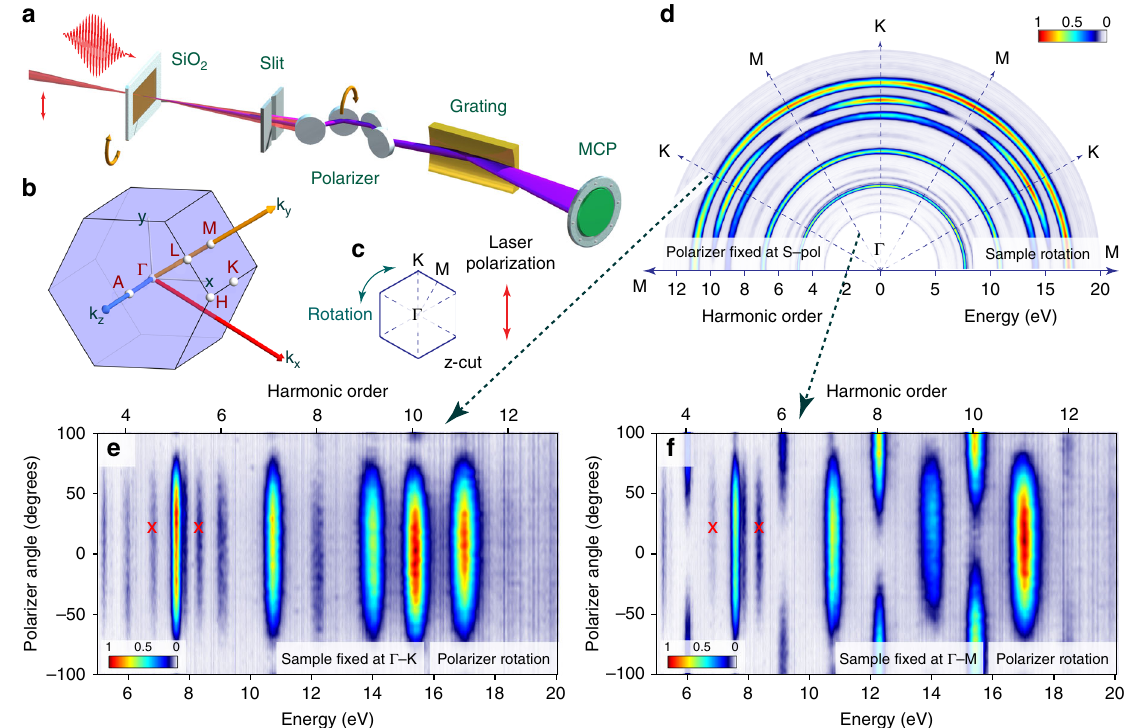
Fig. 2 Unveiling physical mechanisms of even-harmonic generation from the α -quartz. a Experimental apparatus showing the spectral measurement with rotatable target and EUV polarizer. b Perspective view of the Brillouin zone of α -quartz showing both the Cartesian coordinates, as well as k -vectors. c Projection of the Brillouin zone for a z-cut α -quartz crystal. d Recorded spectral intensity (false-color) as a function of the rotation angle of the α -quartz sample. The polarizer is fi xed at S polarization. The incident electric fi eld is a linearly polarized 30 fs pulse at a carrier wavelength of 800 nm. e , f Recorded spectra as a function of the rotation angle of the polarizer, when the α -quartz sample is oriented at the Γ − K and Γ − M directions, respectively. Zero degree corresponds to the polarization direction parallel to the incident linearly polarized electric fi eld. Red crosses denote the second-order diffraction from the grating-based